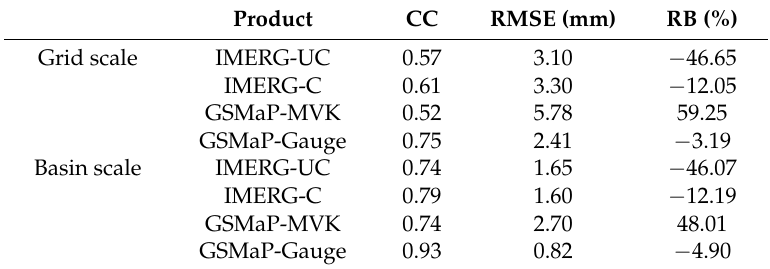
Table 5. Statistical summary of the precipitation products at grid and basin scales for the year of 2015 in the upper Yellow River